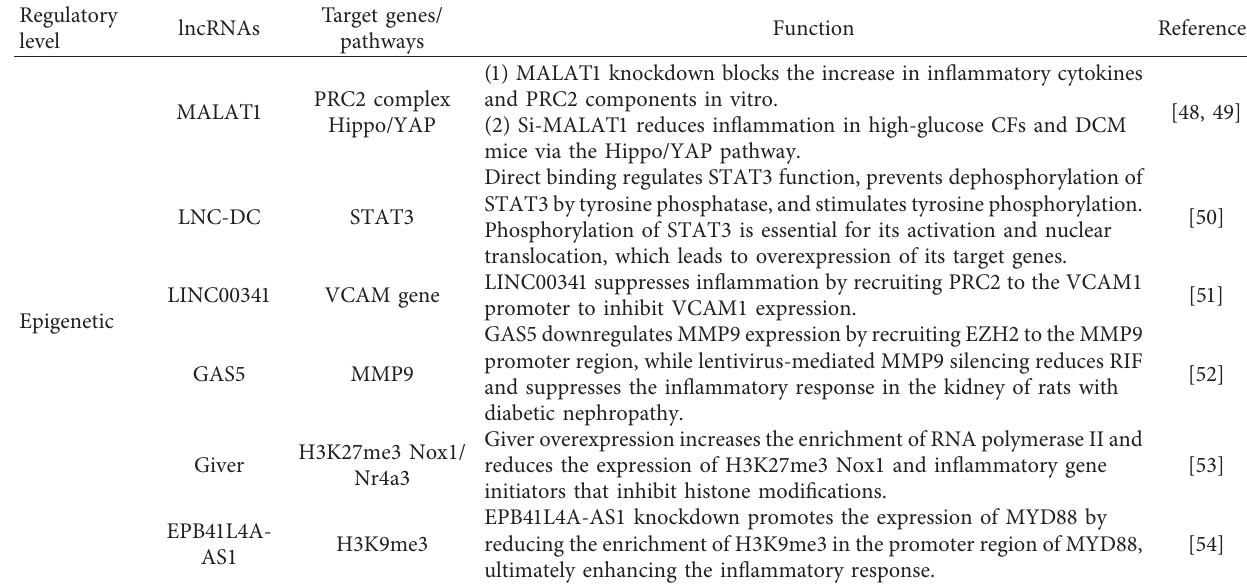
Table 1: The function of lncRNAs at the epigenetic level.